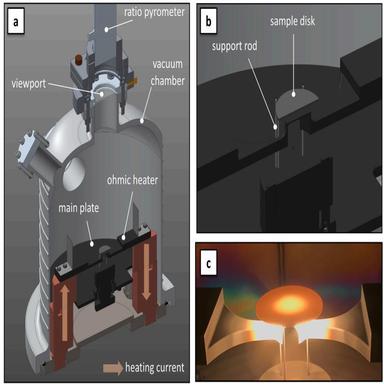
The experimental set-up employed for the emissivity and thermal conductivity estimations; (a) general overview of the test bench; (b) details of the sample support system; (c) picture of the sample and heater at high temperature during a test.